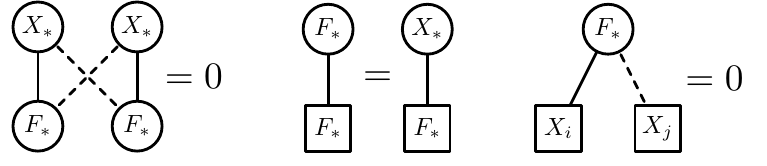
Figure 8: Decorated constraints forcing the structure of the rest of the tiles involving parts from F ∗ .